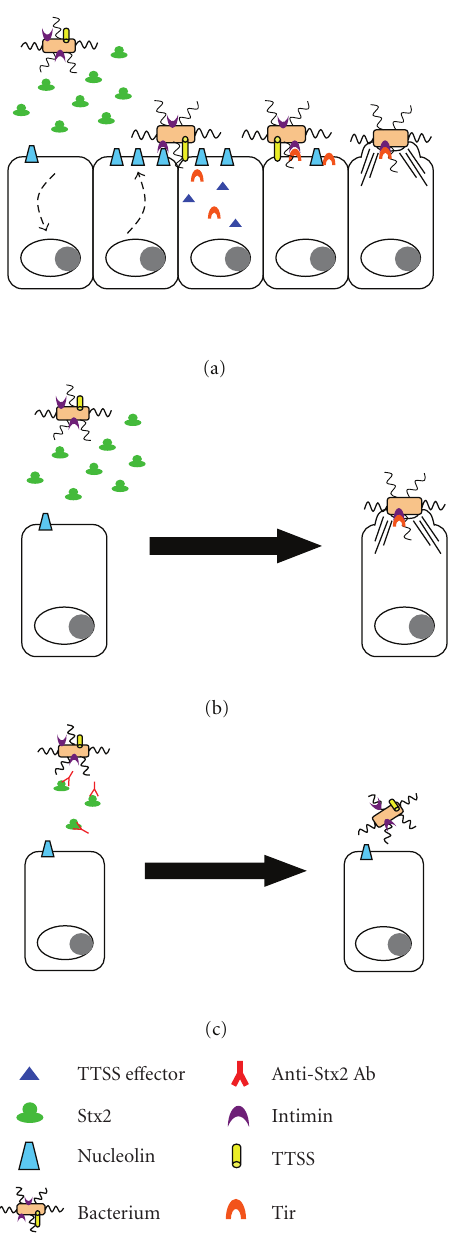
Figure 4: Model of the role of Stx2 in E. coli O157:H7 adherence and colonization. (a) E. coli O157:H7 elaborates Shiga toxin early during the colonization/adherence process. Stx2 exerts an e ff ect on the host cell epithelium that leads to increased levels of cell surface-localized nucleolin. Nucleolin acts as an initial receptor for intimin, an interaction that allows E. coli O157:H7 to bind to the host epithelium and inject Tir and other TTSS e ff ectors into the host cell. Intimin then engages Tir which, coupled with the cellular e ff ects of other TTSS e ff ectors, leads to host cell cytoskeletal rearrangement and formation of the characteristic A/E lesion. (b) Stx2, produced by the wild-type organism or provided to a stx 2 mutant, facilitates colonization of the gastrointestinal tract. (c) Neutralizing anti-Stx2 antibody present prior to and during E. coli O157:H7 infection results in reduced levels of E. coli O157:H7 colonizationof the gastrointestinal